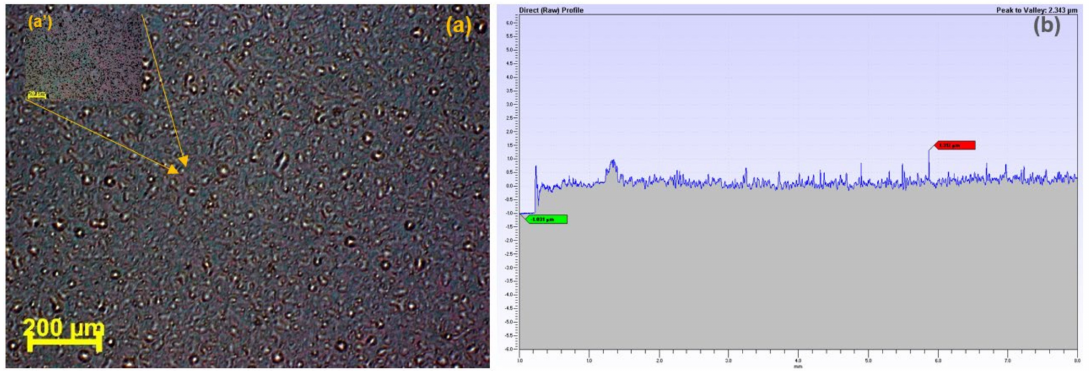
Figure 4. Optical microscopy images (in BF mode) at ( a ) 10 × and ( a’ ) 100 × magnification; ( b ) thickness of the thin